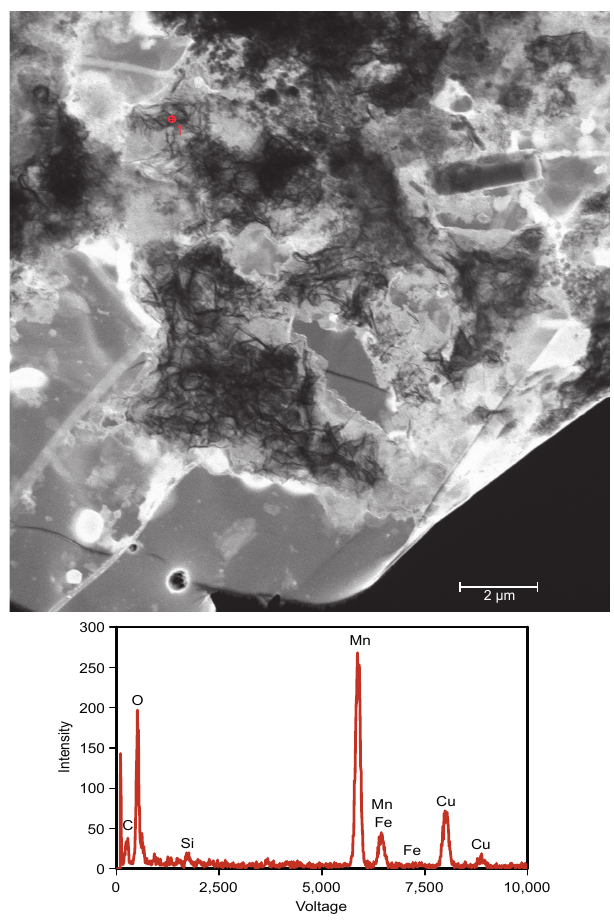
Fig. 7. TEM micrograph of particles collected from 118.6m depth. Aggregates of dark, fibrous minerals seen in the TEM image are similar in morphology to birnessite (Cheney et al., 2008), and an EDS spectrum collected from the point indicated with red crosshairs shows predominately Mn and O present.